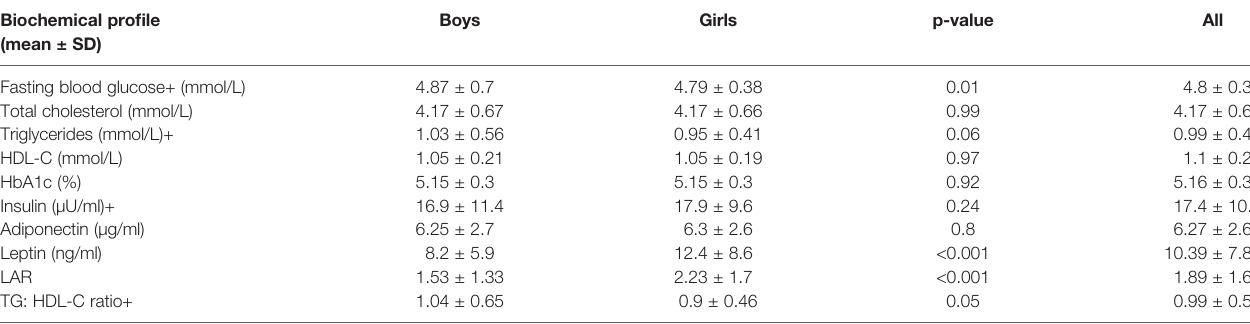
TABLE 2 | Biochemical measures.